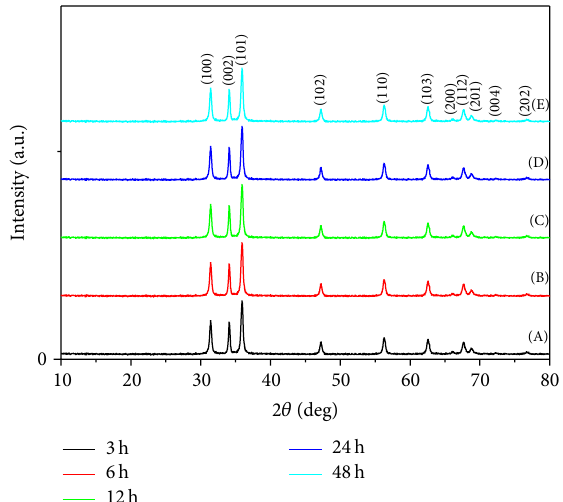
Figure 7: XRD patterns for ZnO nanopowders via sol-gel technique with different reaction times: (A) 3 h, (B) 6h, (C) 12 h, (D) 24 h, and (E) 48